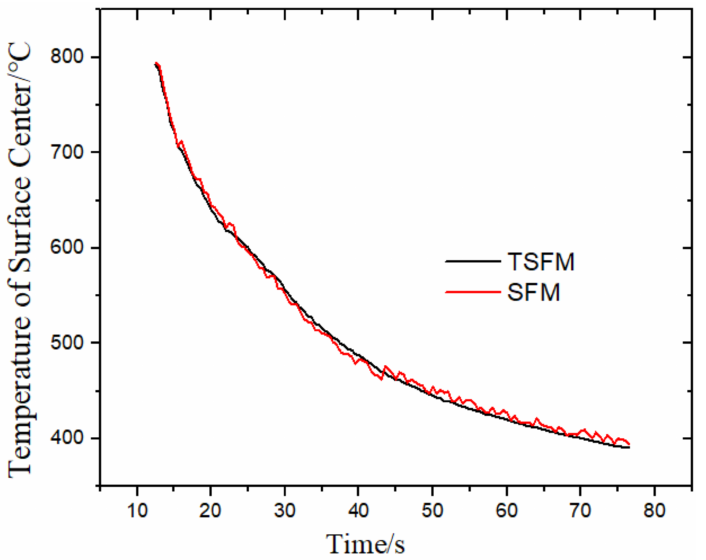
Figure 10. Comparison of the surface center temperature calculated by two methods.